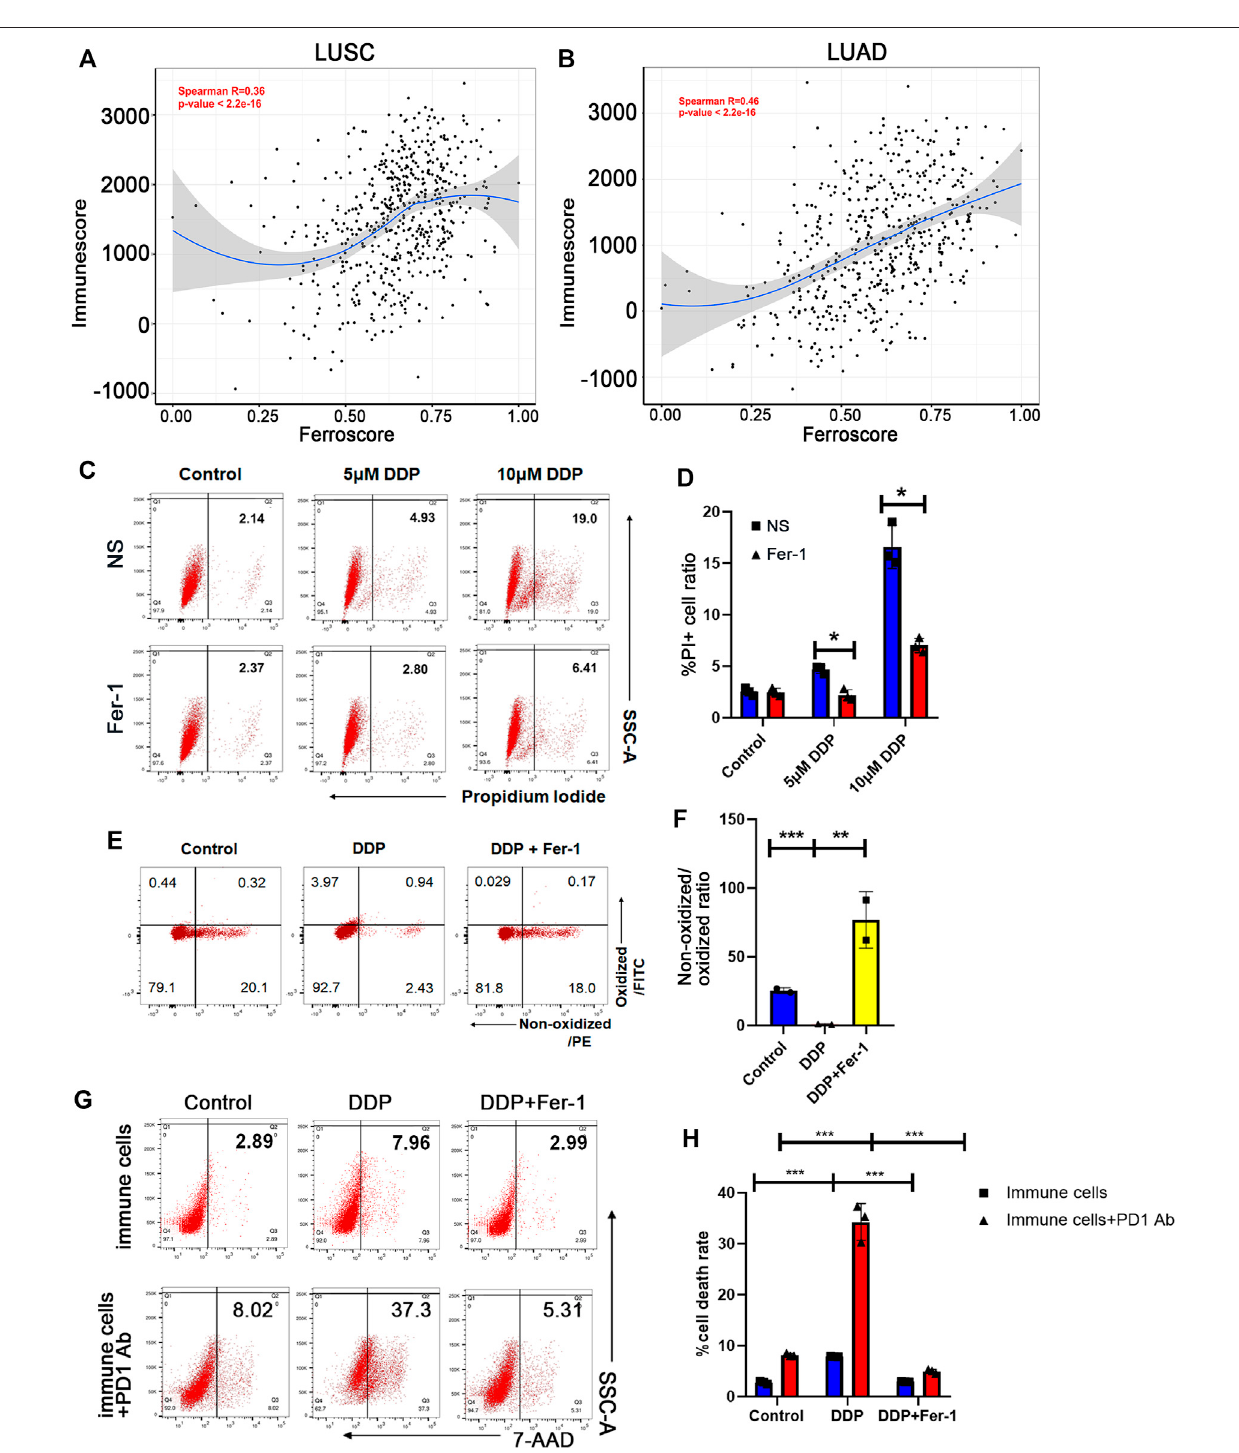
FIGURE1| Cisplatinpromotedtumorferroptosisthatwascorrelatedwithimmunescore. (A) and (B) TheferroscorecorrelatedwithimmunescoreinLUSC (A) and LUAD (B) cohorts ofTCGA database. (C) Cell death ratio of A549 cells treated with 5 μ M cisplatin (DDP) or 10 μ M DDP for 8 h measured by fl ow cytometry (NS: normal saline). (D) Quanti fi cation ofdatain (C) . (E) Lipid peroxidation ofA549cells treated with10 μ M DDP or rescued by 10 μ M ferrostatin-1(Fer-1) for 8 h determined by fl ow cytometry. (F) Quanti fi cation of data in (E) . The ratio of non-oxidized lipid (PE)/oxidized lipid (FITC) fl uorescence intensities decreases in DDP-treated cells, indicating that DDP induces lipid peroxidation, while ferrostatin-1 rescued this effect. (G) Cell death ratio of A549 cells co-cultured with immune cells before or after anti- PD1antibodytreatment,determinedby fl owcytometry.TheimmunecellswerepretreatedwithsupernatantofA549cells,whichweregivenDDPorDDPplusferrostatin- 1. (H) Quanti fi cation of data in (G) . DDP could increase cytotoxic effect of immune cells and anti-PD1 antibody ef fi cacy, which would be rescued by ferrostatin-1. Bar graphs represent the mean ± SD of indicated samples. p p < 0.05, pp p < 0.01, ppp p < 0.001.